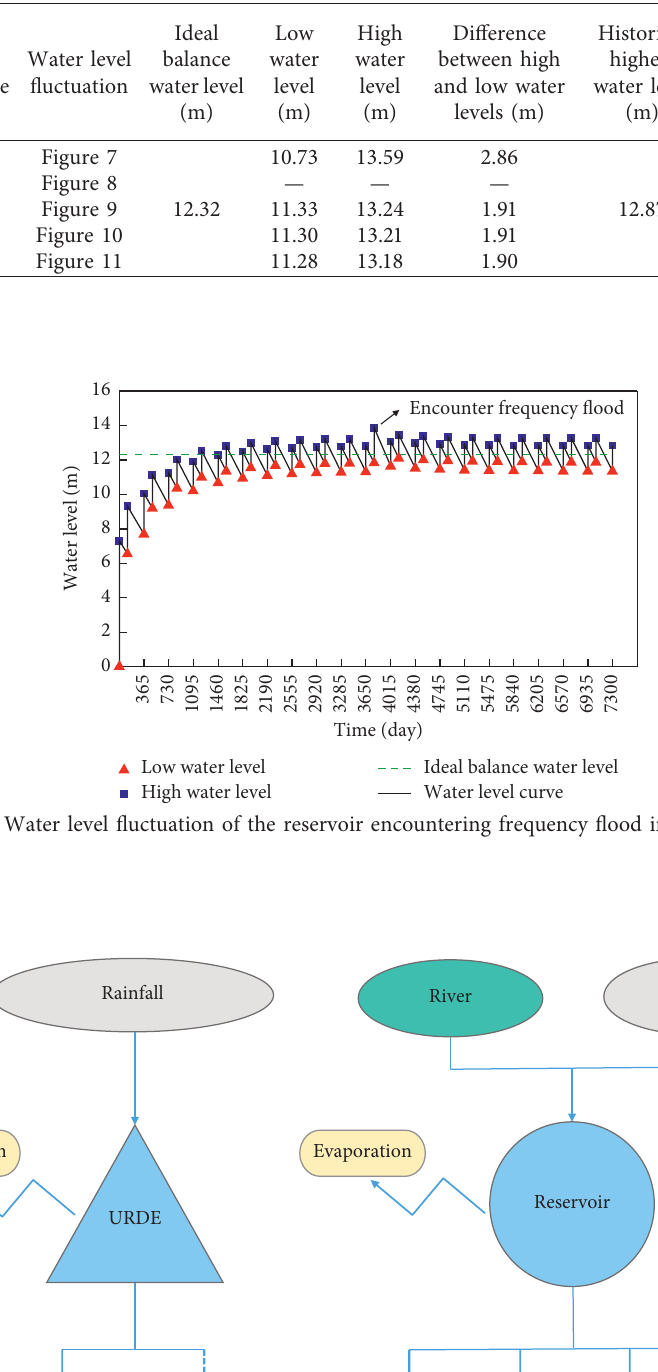
Table 3: Summary and comparison of water level values for the 20th year.